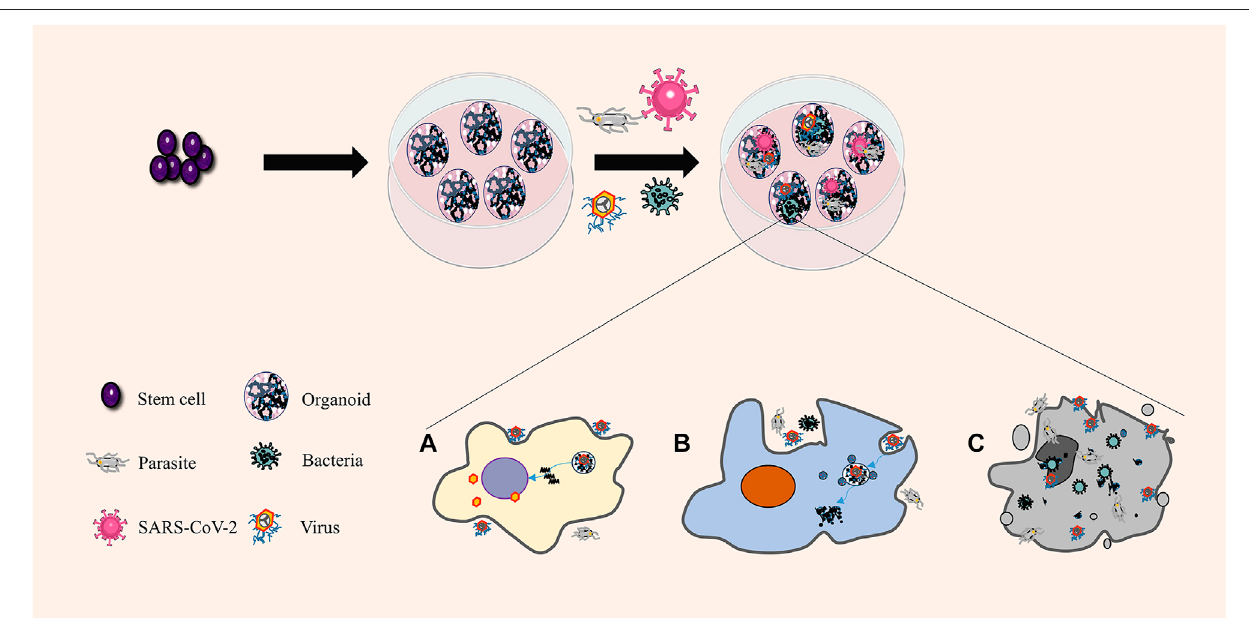
FIGURE 3 | Organoids in infectious diseases. Organoids are unique and composed of various differentiated cells. Different cells can connect with the pathogens simultaneously and react differently inthe same organoids, consistent withthe response ofthehumanbody. (A) Pathogenic microorganisms use thehost toreproduce. (B) The pathogenic microorganism is killed and decomposed by the host. (C) Host cell lysis and death.